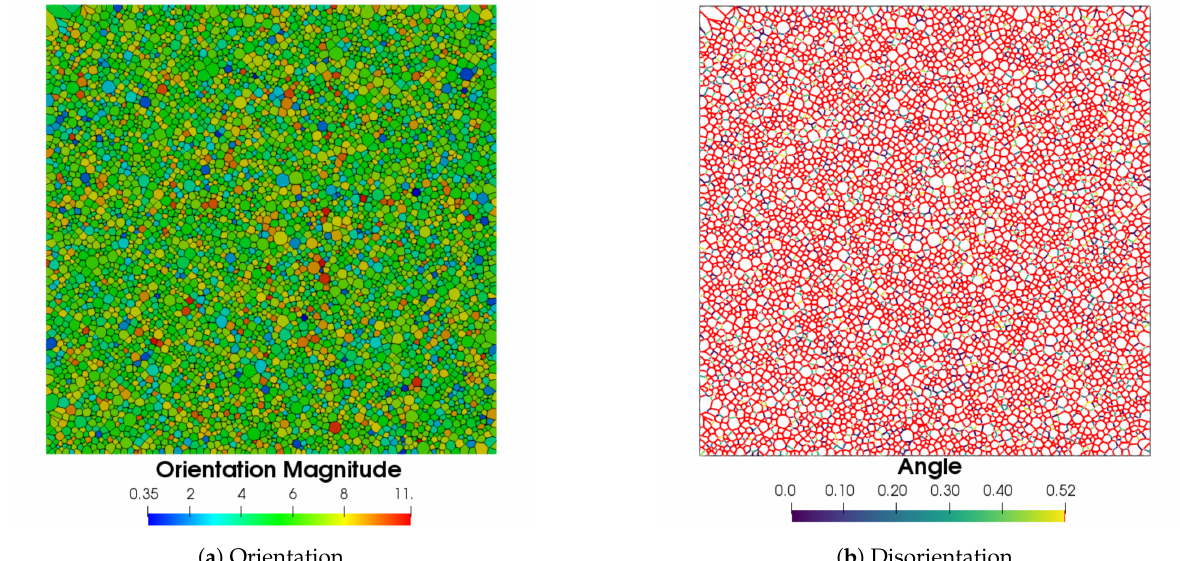
Figure 12. Initial crystallographic